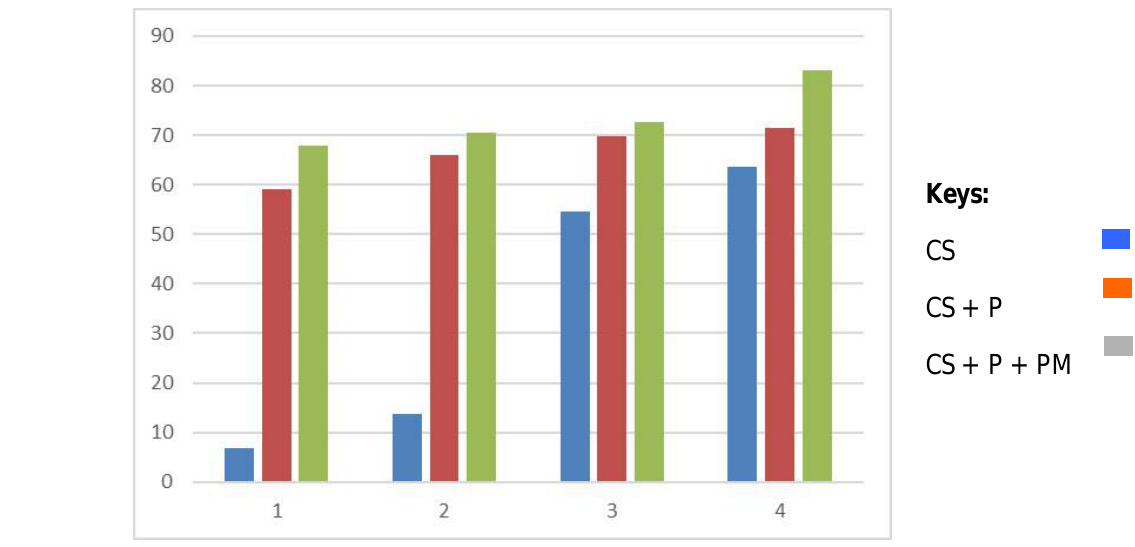
Figure 3. Percentage biodegradation of used motor oil in contaminated soil